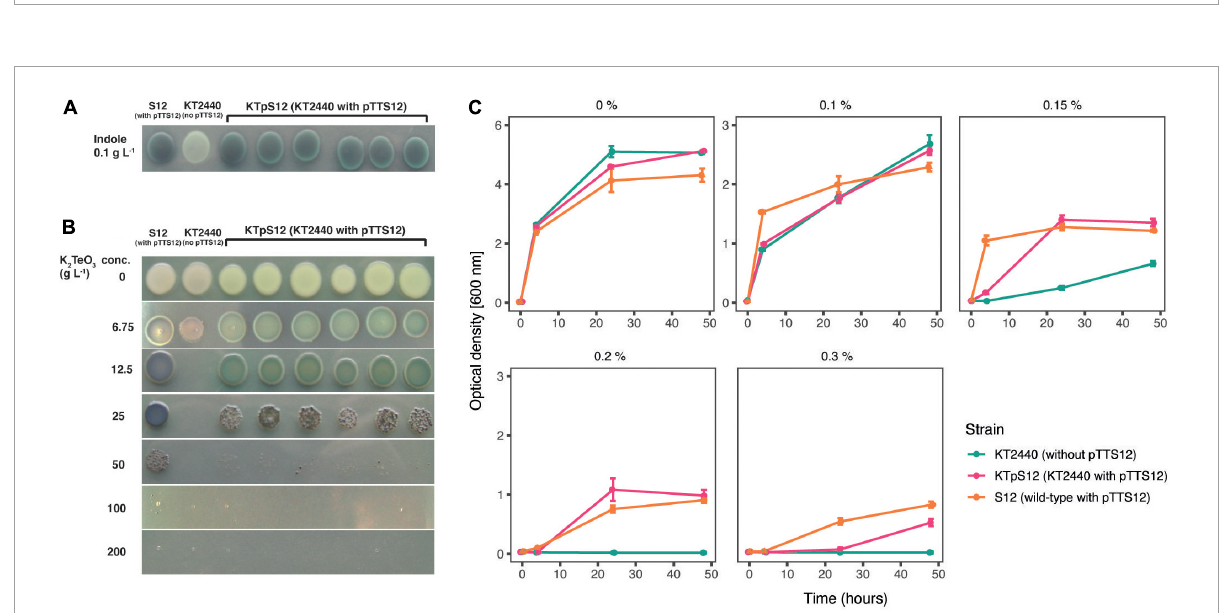
FIGURE5 Transfer of pTTS12 phenotypic characteristics. (A) Production of indigo from indole indicating activity of styrene monooxygenase (StyA) and styrene oxide isomerase (StyB). Minimal medium (M9) was supplemented with indole which, in the presence of StyAB enzymes encoded on pTTS12, is converted into indigo. Positive control P. putida S12 showed indigo coloration, whereas negative control P. putida KT2440 remained white. P. putida KTpS12 showed indigo coloration indicating activity of pTTS12-encoded styAB . (B) Growth of P. putida strains in the presence of potassium tellurite (K 2 TeO 3 ). Minimum inhibitory concentration (MIC) of positive control P. putida S12 was 200 g L - 1 whereas the MIC of the wild-type P. putida KT2440 was 12.5 g L - 1 . The MIC of P. putida KTpS12 was 100 g L - 1 indicating the presence and activity of the ter operon on pTTS12. (C) Growth of P. putida strains on increasing concentrations of toluene. Optical density (OD 600 nm ) of the cultures was measured at 4, 24, and 48-h time points with starting point of OD 600 nm = 0.1. The y-axis range is different between the first panel (0–6) and the other panels (0–3). Green dots indicate P. putida KT2440, magenta dots indicate P. putida KTpS12, and orange dots indicate P. putida S12 (containing pTTS12). P. putida KTpS12 showed an increase in solvent tolerance indicating the presence and acivity of the srp operon from